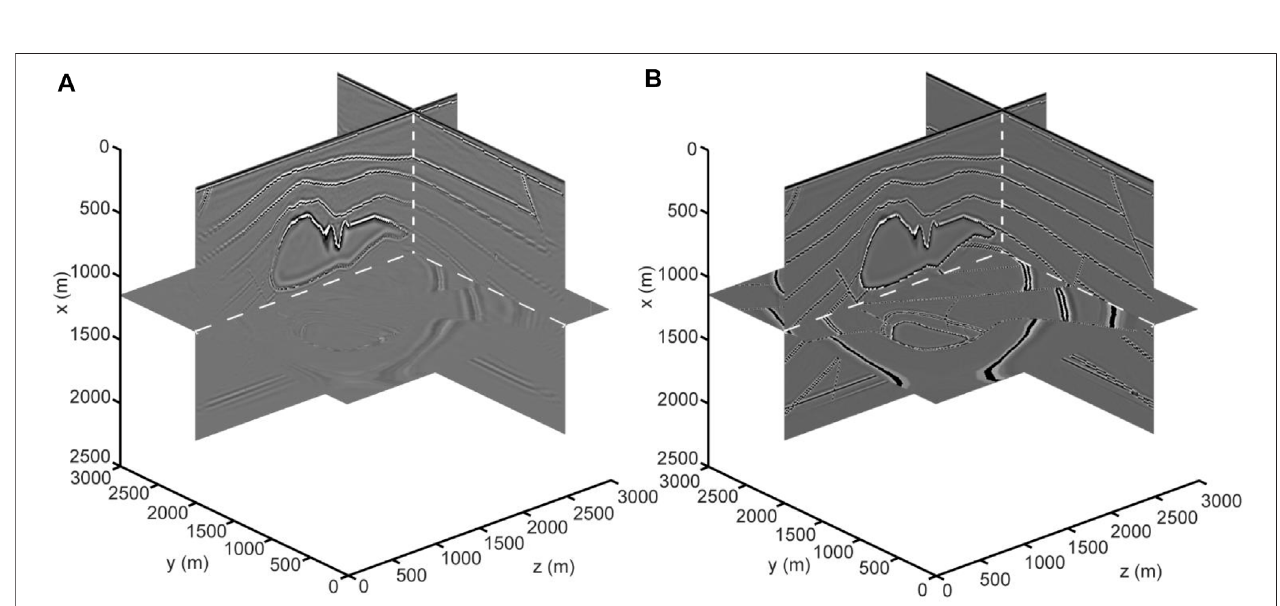
FIGURE 7 | (A) The migration image using the vector fi eld dot product cross-correlation imaging condition by Wang and He (2017). (B) The migration image using the imaging condition of Eq. 6 . Both two migration images use the fi rst-order velocity-dilatation-rotation equations.